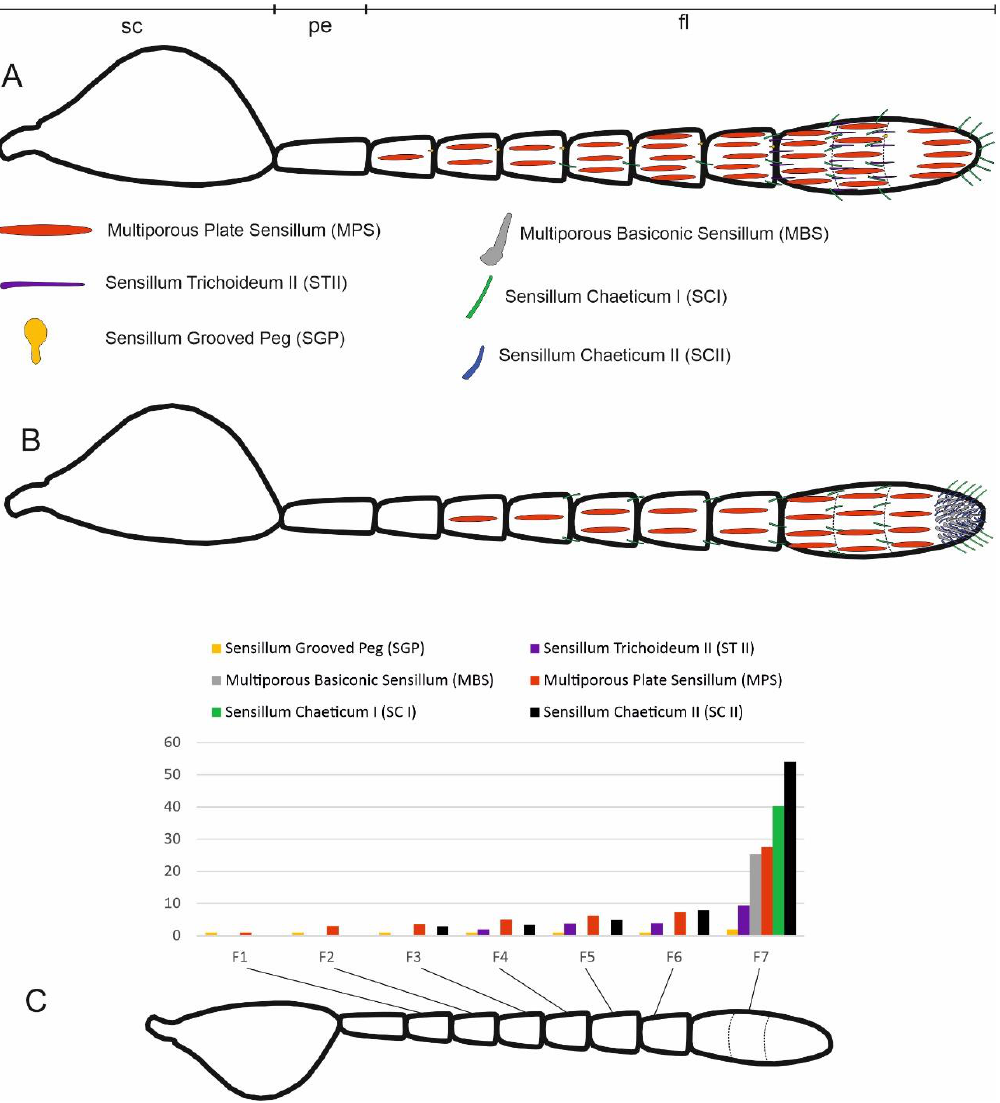
Figure 3. Schematic drawing of Anagyrus vladimiri female antennae from dorsal ( A ) and ventral ( B ) views. The different types of sensilla are reported with their relative distribution. Sensilla trichoidea I are omitted. ( C ) Graph showing the relative abundance of the different sensilla types on the different flagellomeres (numbered from F1 to F7). Sc, scape; pe, pedicel; fl, flagellum.